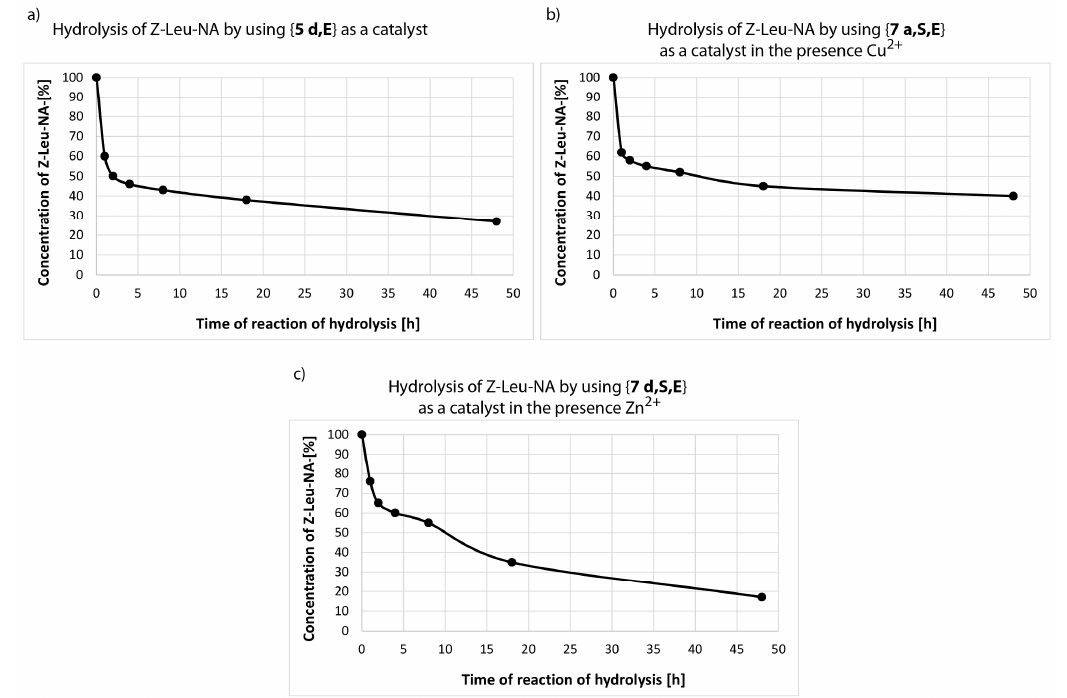
Figure 10. Progress of hydrolysis based on HPLC monitoring the concentration of Z-Leu-NA in the presence of N-hexadecanoyl-Glu-NH-C 6 H 4 -DMT-celulose { 5 d,E } ( a ); in the presence of N -heptanoyl-Ser-Glu-NH-C 6 H 4 -DMT-celulose { 7 a,S,E } as a catalyst in the presence Cu 2+ ( b ); in the presence of N -heptanoyl-Ser-Glu-NH-C 6 H 4 -DMT-celulose { 7 d,S,E } as a catalyst in the presence Zn 2+ ( c ).